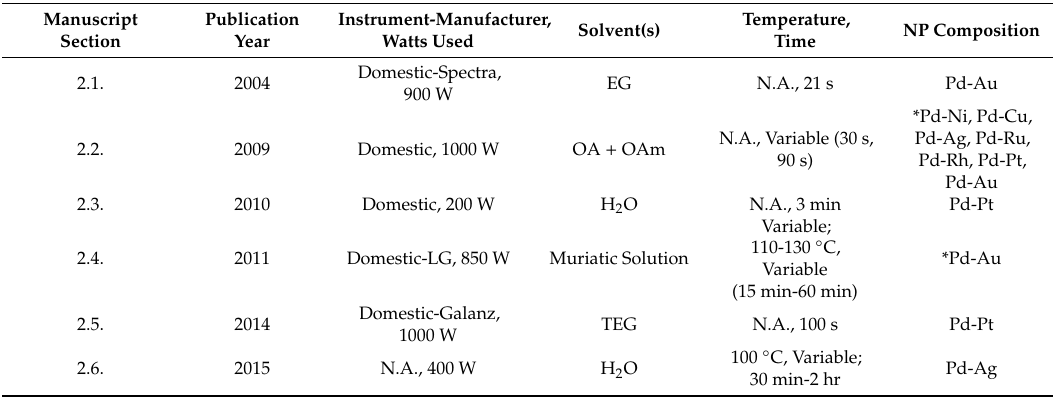
Table 3. Summary of studies covered in this